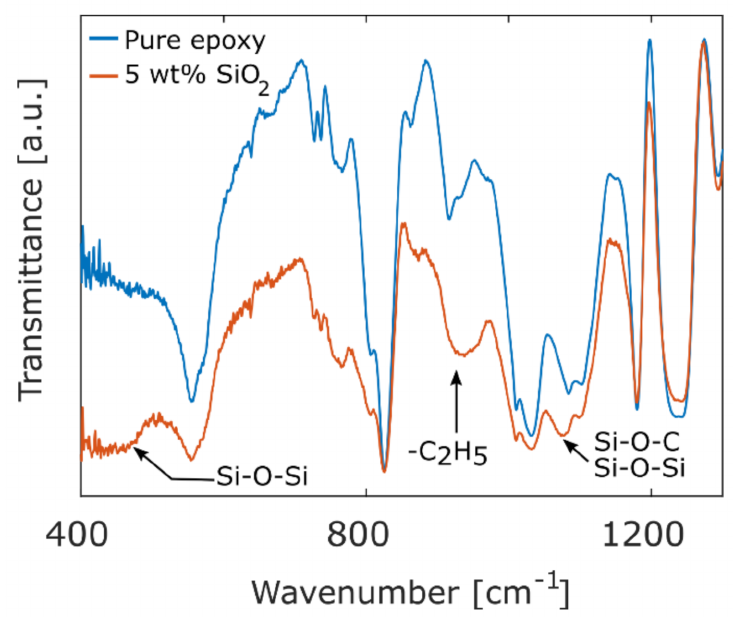
Figure 5. FTIR spectra of pure epoxy and epoxy-SiO 2 nanocomposite with 5 wt.% SiO 2 at pH 7. The relevant differences in the spectra are